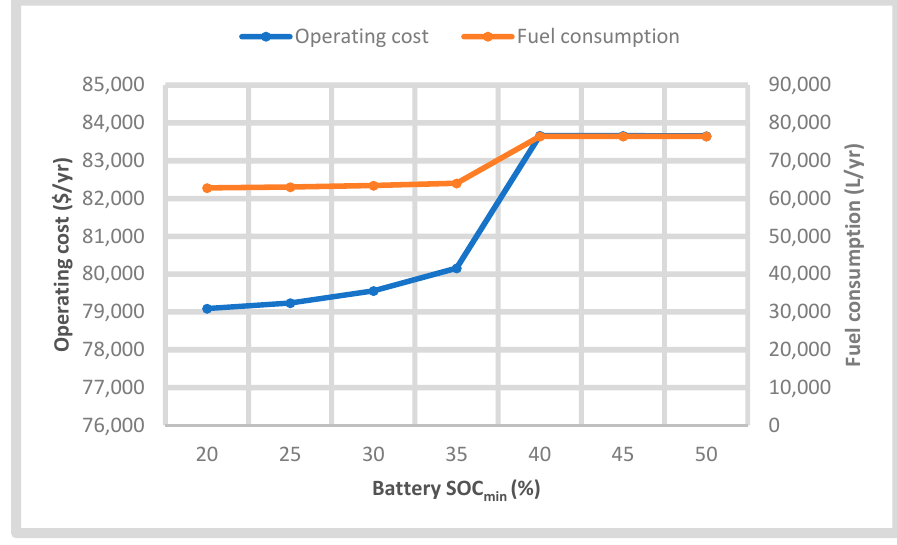
Figure 20. Effect of battery SOC min on the operating cost and fuel consumption rate of the HES.